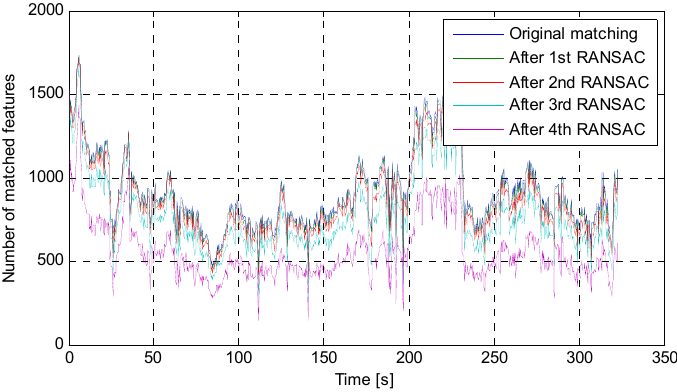
Figure 3. Number of matched features after implementing multilayer